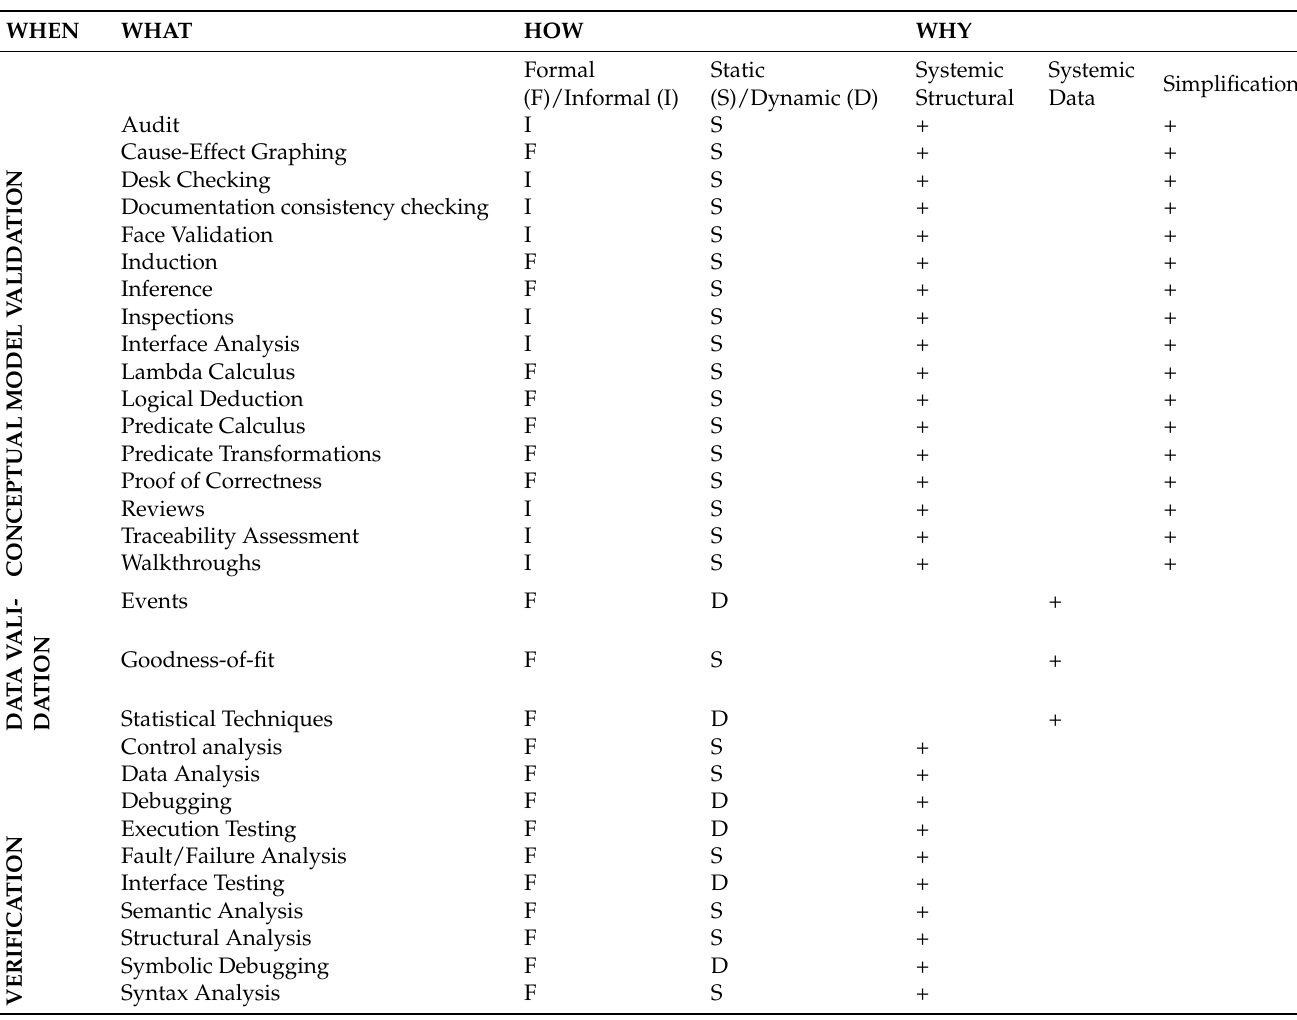
Table 3. The final classification of the assumptions validated in each test depends on how the team is implementing the tests, but this table helps in the understanding of where to put the effort in the validation process. Finally, all the different validation processes must be done, and ideally, all the assumptions must be tested through the different validation